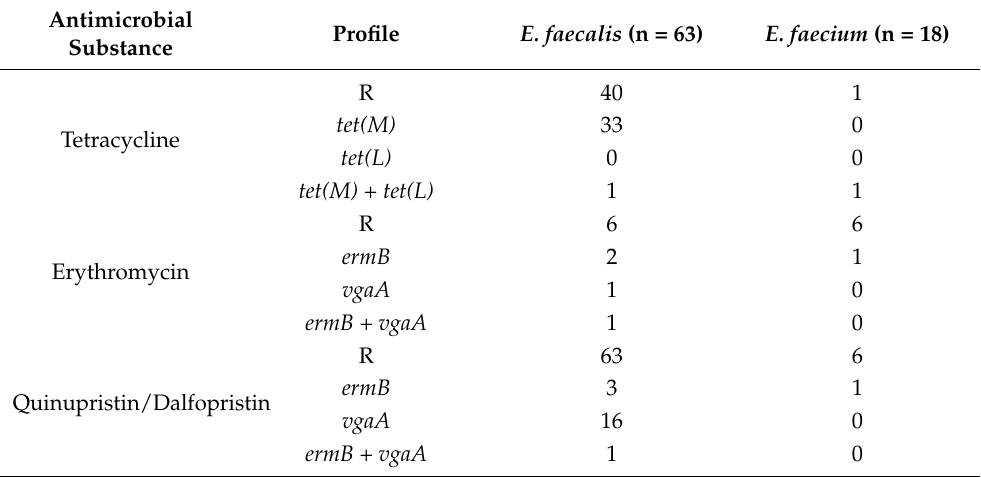
Table 4. Resistance gene patterns in Enterococcus faecalis - and Enterococcus faecium -resistant strains.